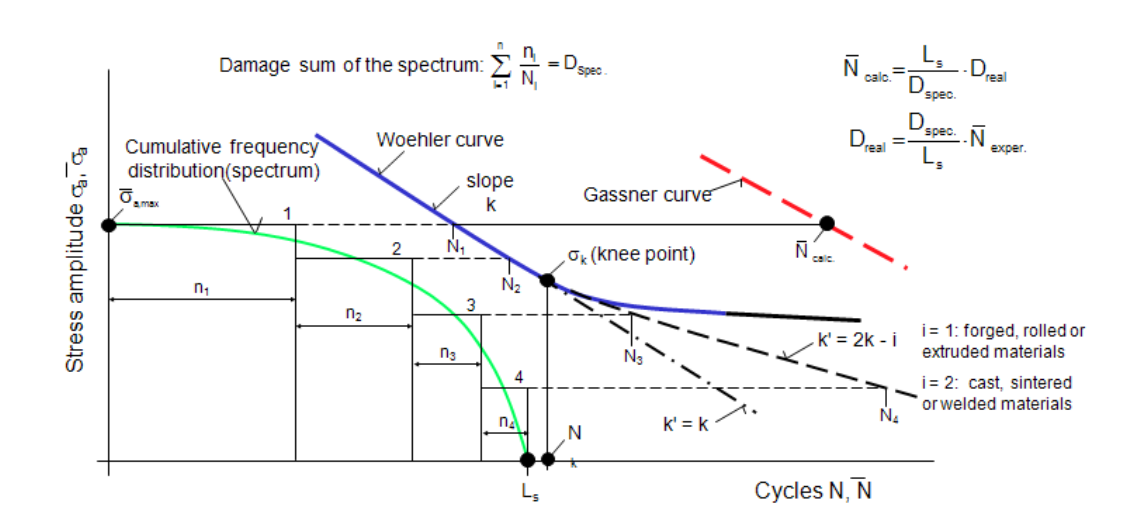
Figure 10: Modification of the SN-curve and calculation of fatigue life (schematically).